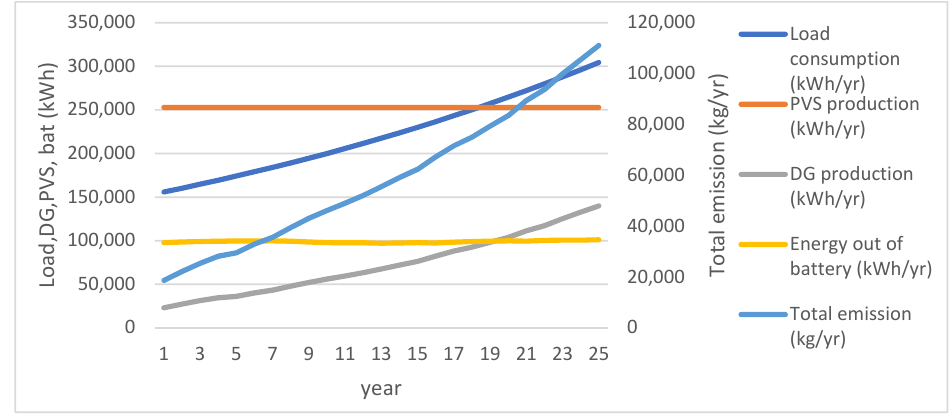
Figure 16. Variation of generation, load and total emission using a HOMER multi-year model.